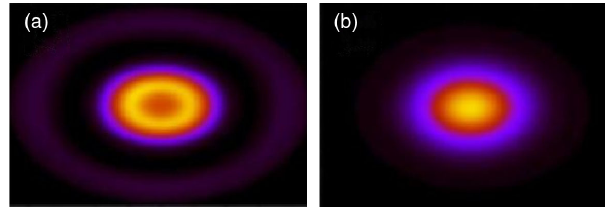
.FIG. 5. Transverse optical field profile at the out-coupled mirror: for the (a) Gaussian, and (b) hollow, electron beams, both at g ¼ − 0 . 6 and λ ¼ 10 μ